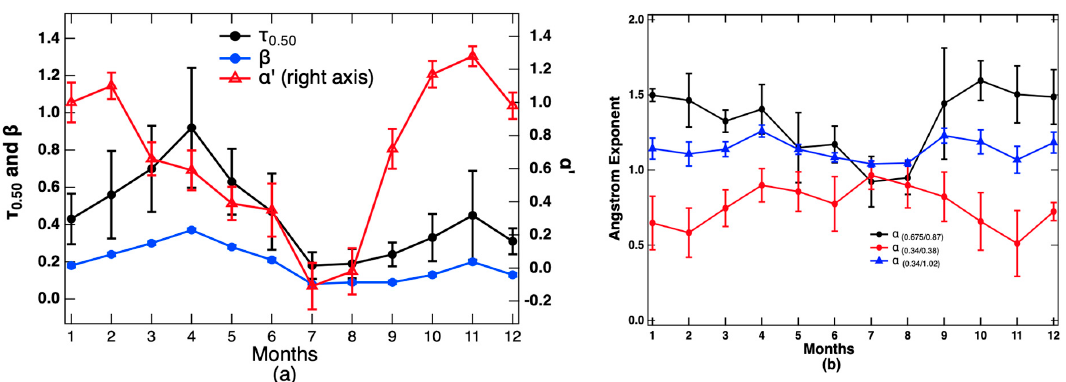
Figure 5. Time series of ( a ) Aerosol Optical Depth at 0.50 μ m and Ångström Turbidity Parameter β and curvature of the curve. ( b ) Ångström Exponent in different wavelength pairs.